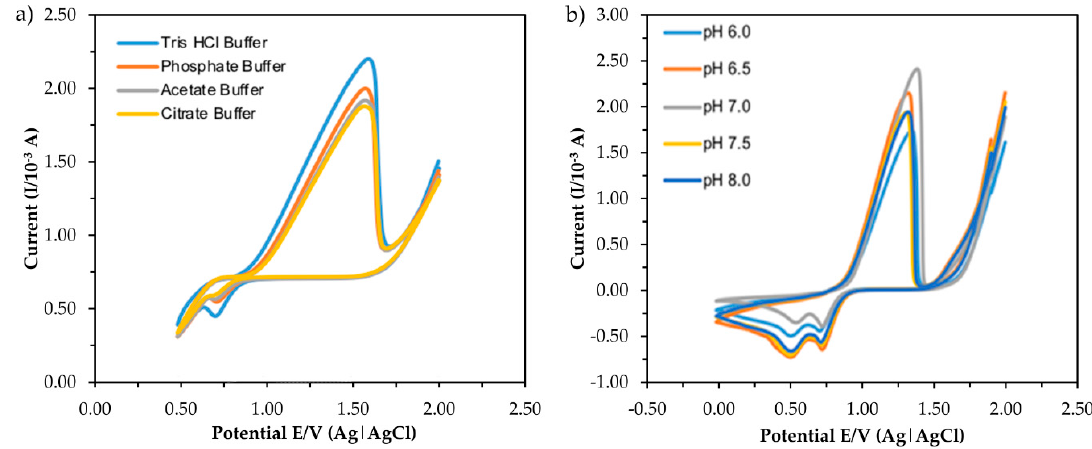
Figure 6. CV responses of di ff erent type of bu ff er ( a ) and pH ( b ) in the presence of 6 ppm mercury.